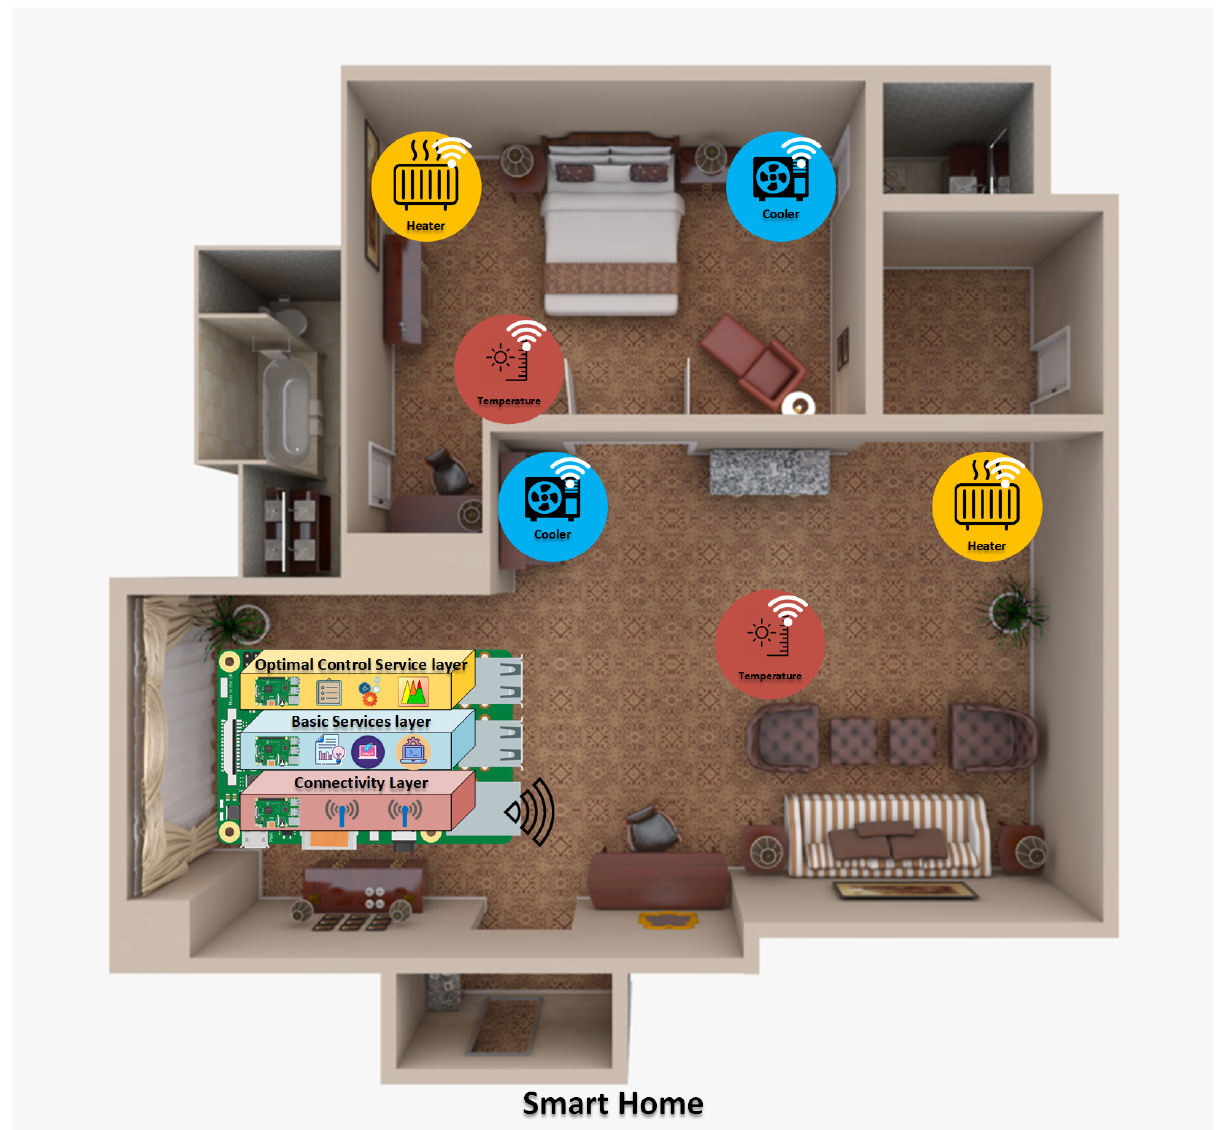
Figure 1. Conceptual Distributed Edge Computing Architecture of a Home Appliances